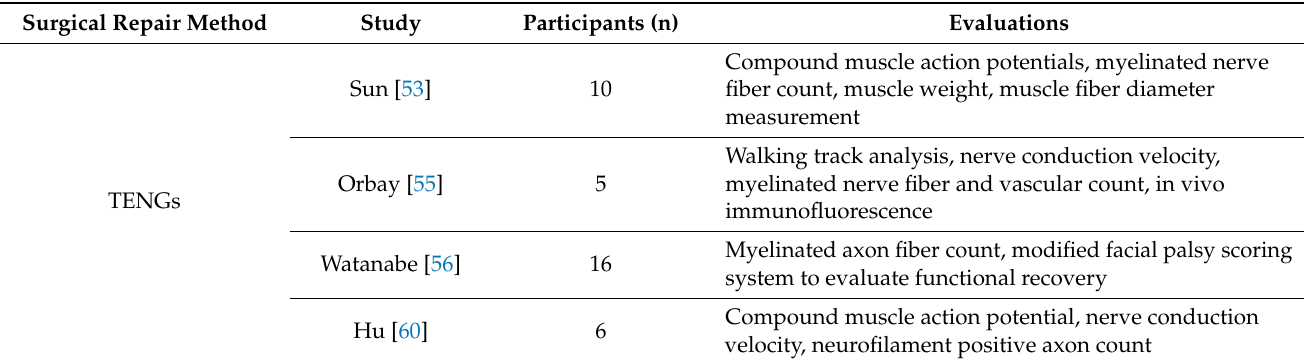
Table 3. Participant number and outcome evaluations from studies of animal nerve surgeries with use of TENGs and ADSCs. Note that Hu’s study used MSCs instead of ADSCs. Only studies that evaluated at least one functional outcome are listed in the